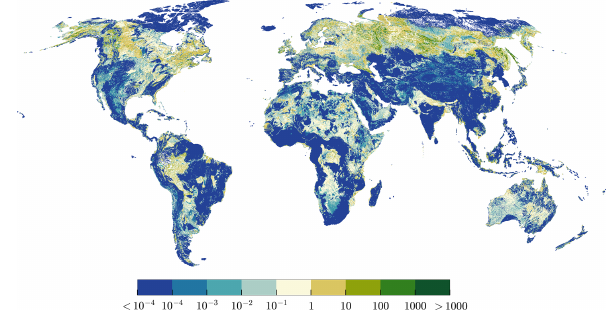
Figure 4. Absolute coefficient of variation ( σ(h)µ( | h | ) − 1 ) (%) of simulated h per cell over all Monte Carlo realizations. Yellow indi- cates that h results changed very little, white to gray values indicate a growing difference in model results, and red values indicate a very high variation of h over all model realizations.